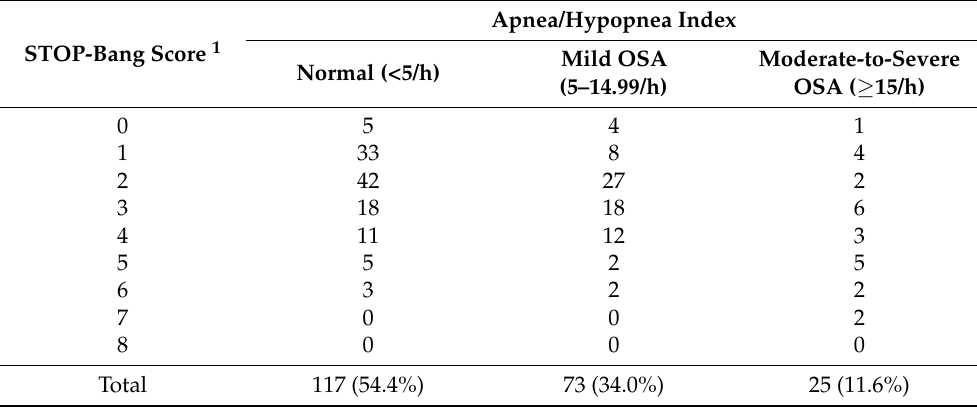
Table 2. Number of participants with sleep apnea vs. positive STOP-Bang Model responses.